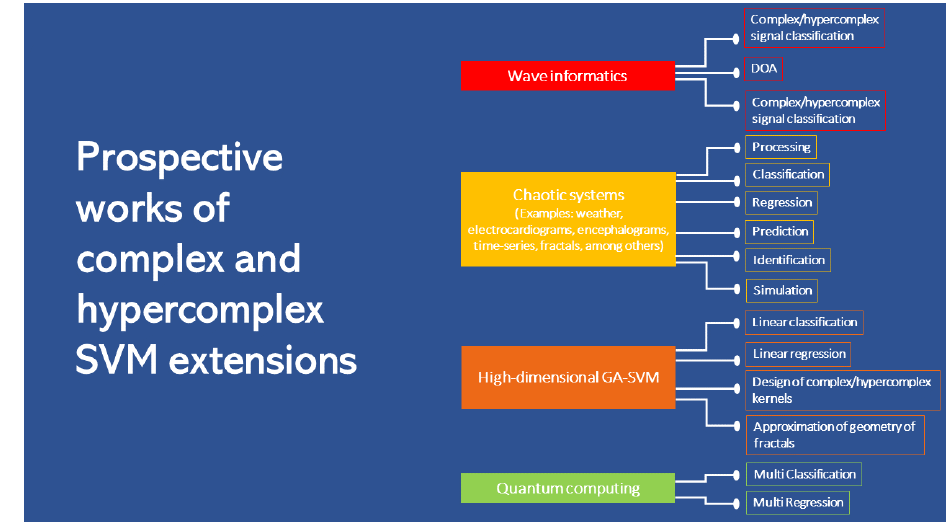
Figure 1. Prospective works of complex and hypercomplex SVM